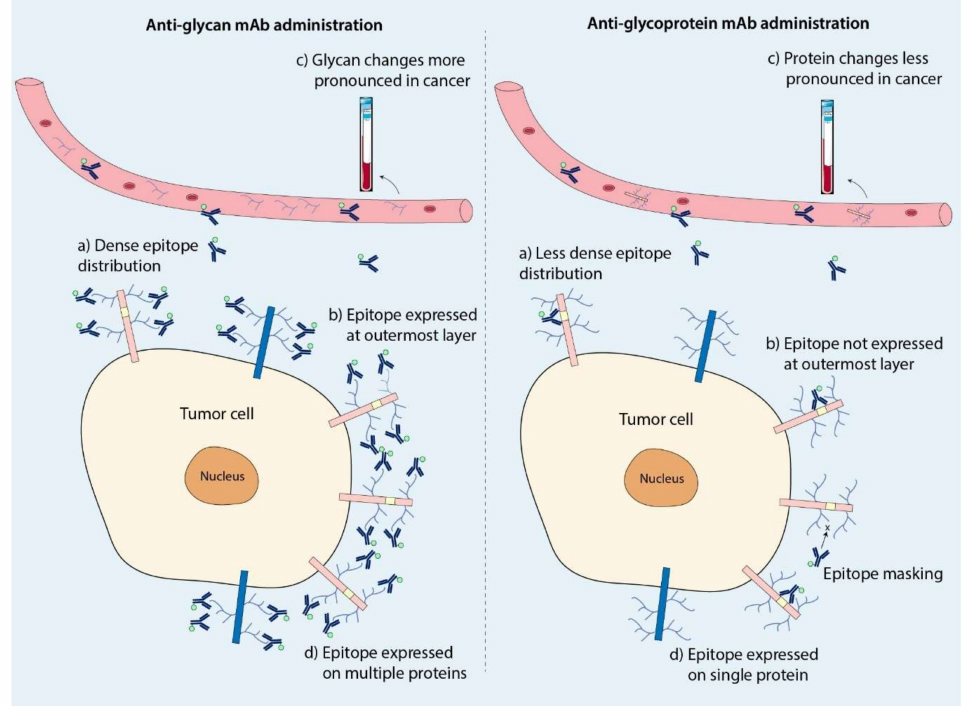
Figure 3. Schematic comparison of glycan-targeting versus traditional (glyco)protein targeting for molecular imaging of tumors. ( a ) Tumor-associated glycans (dark blue branches) are densely packed on multiple proteins (displayed in pink and dark blue) with higher density than binding epitopes on tumor-associated proteins (displayed in yellow). This may result in a denser accumulation of conjugated antibodies, subsequently enhancing tumor signal during imaging. ( b ) Glycans form the outer layer of proteins, making them easily accessible to administered targeting moieties. Noteworthily, glycans may mask binding domains on proteins, challenging specific binding of protein-directed targeting